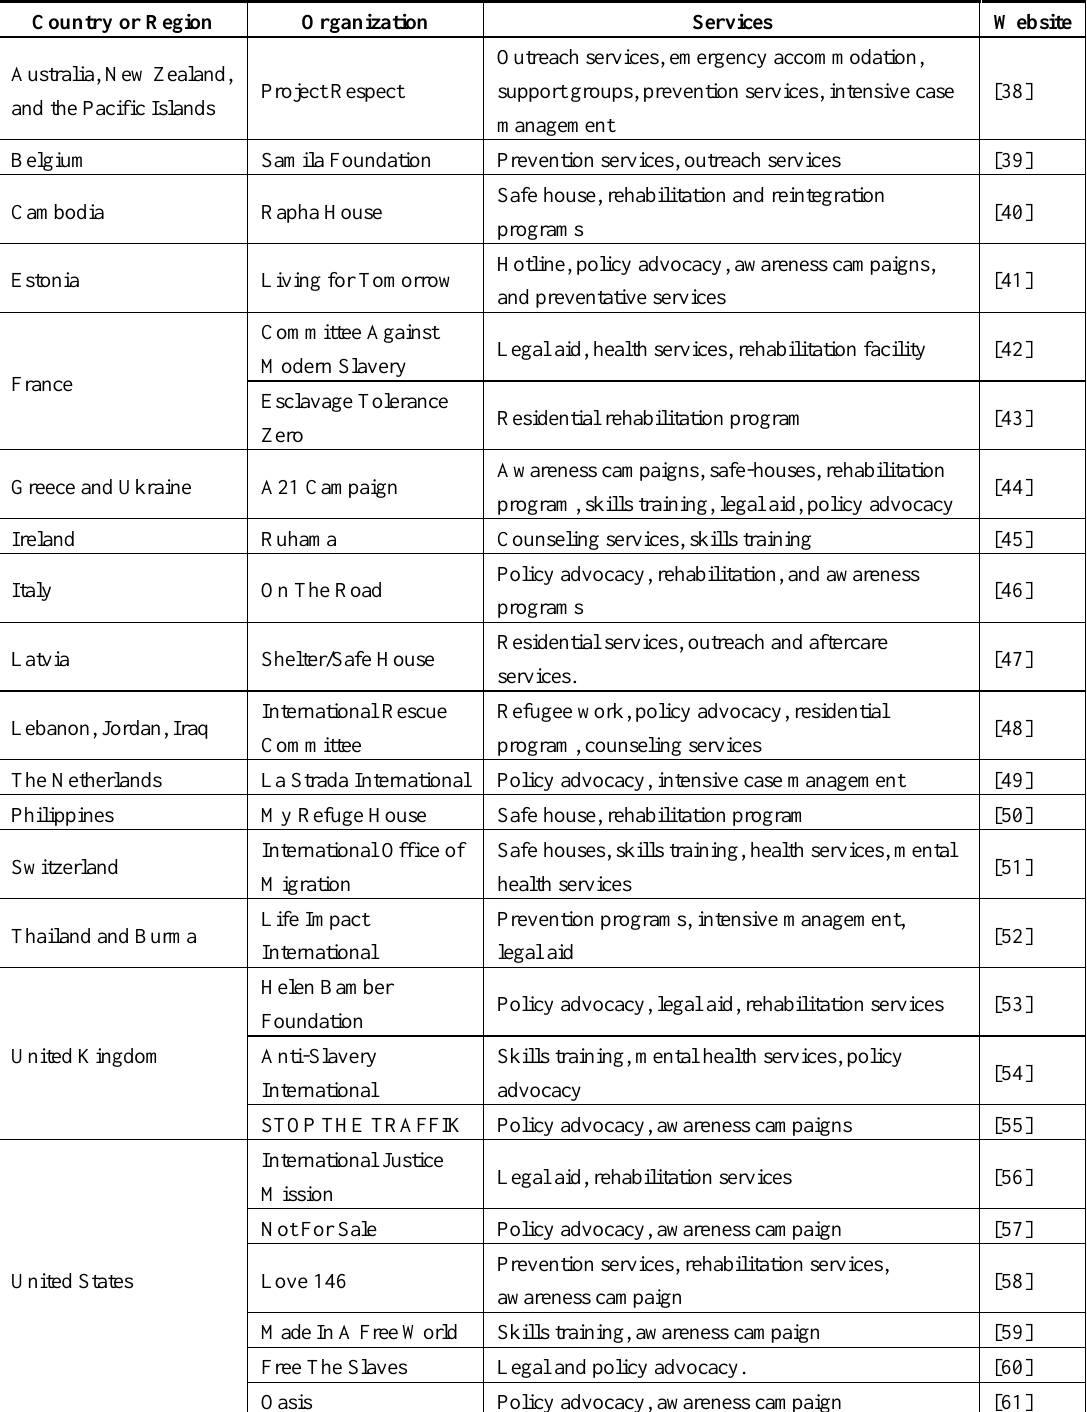
Table 1. International anti-slavery and human trafficking programs, alphabetical by country or geographic region